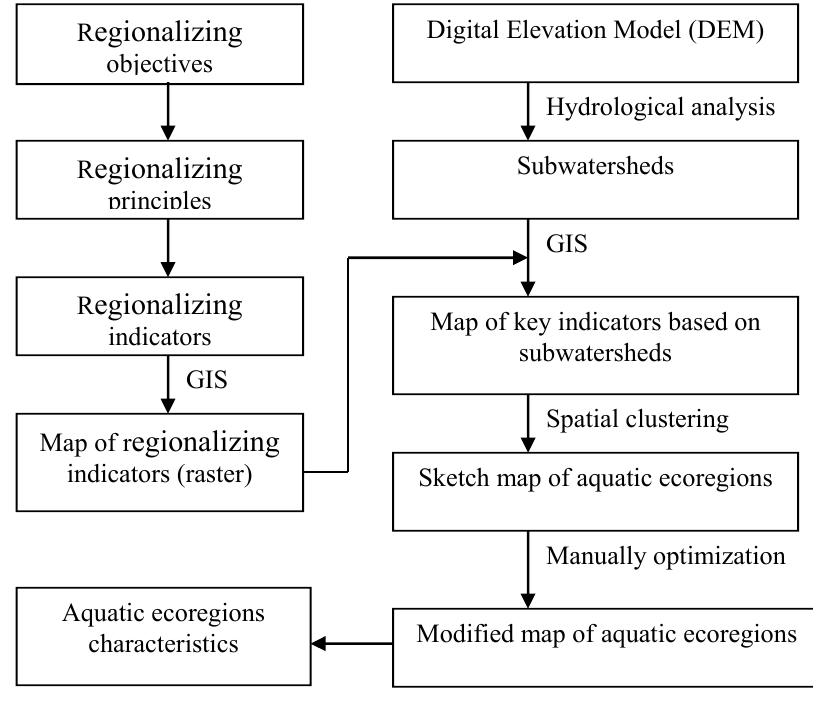
Figure 1. Technical flow to delineate level I and II aquatic ecoregions in the Taihu Lake